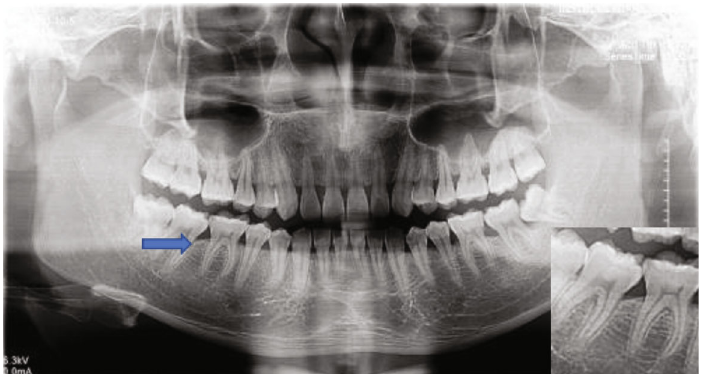
Figure 1: 47 mesoangular absorption.